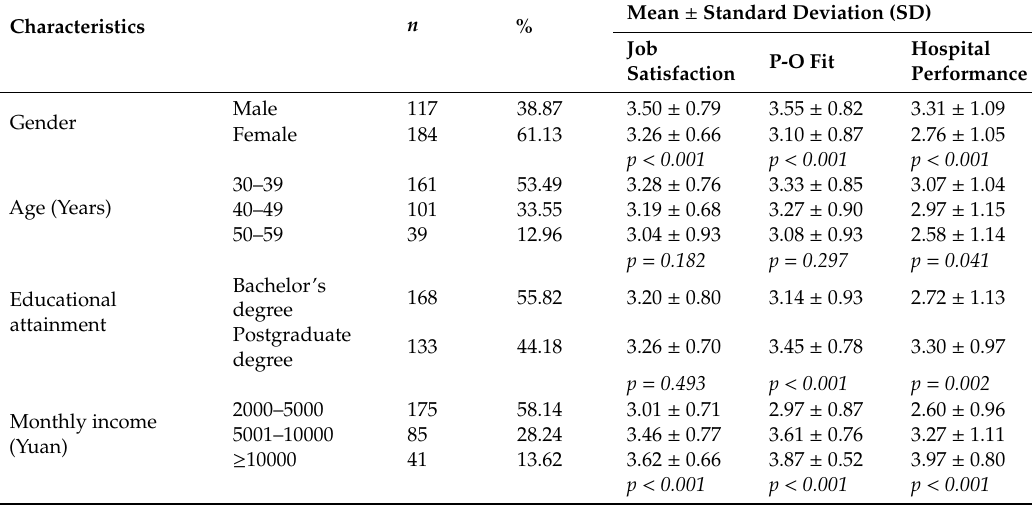
Table 1. Sociodemographic characteristics and measurement (job satisfaction, P-O fit, hospital performance) scores of study